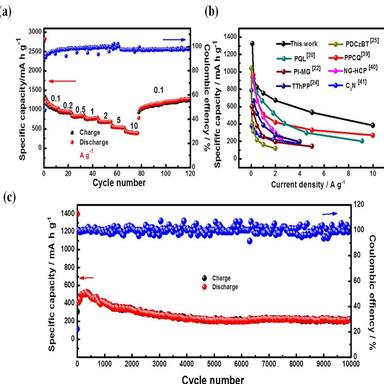
(a) Rate capability of cPAN nanofibers at 0.1–10 A g−1 ; (b) the comparison of rate performance with other N-polymer in the literatures; (c) Prolonged cycling stability of cPAN nanofibers at 10 A g−1 .